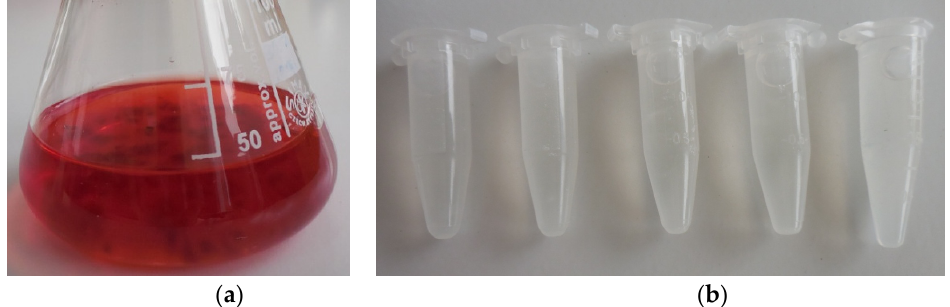
Figure 3. ( a ) Pigment production from pellets of T. albobiverticillius 30548 using PDB media in shake flasks with silicone stopper on day 5; ( b ) growth of the same pellets in Eppendorf tubes on day 5 without any pigment production.